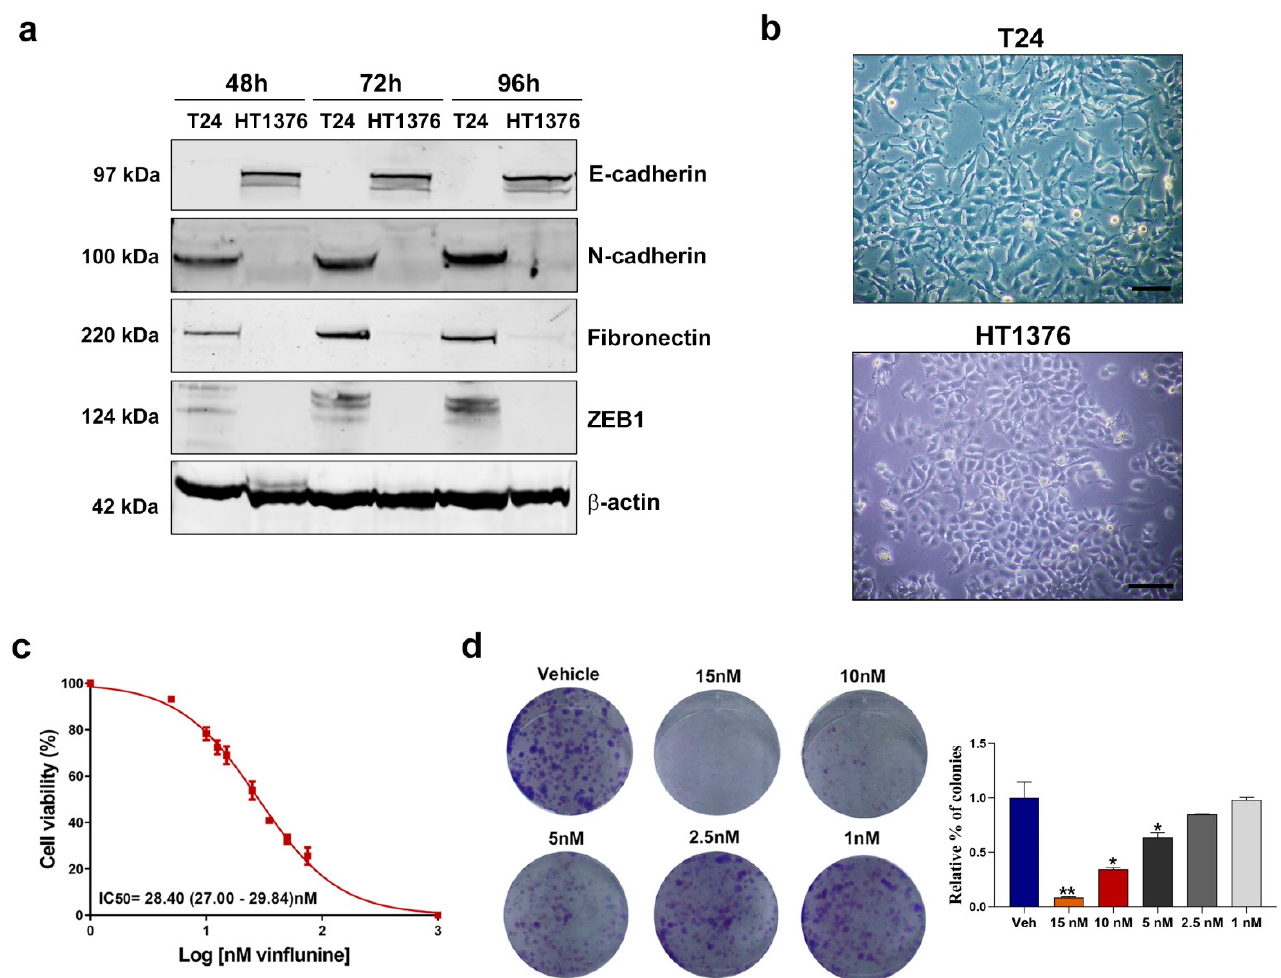
Figure 4. Basal protein expression levels of EMT markers in UCC cells and the effect of vinflunine on T24 cell proliferation. ( a ) Western blot analysis of E-cadherin, N-cadherin, Fibronectin and ZEB1 in T24 and HT1376 cells at 48, 72 and 96 h post-cell seeding. Beta-actin was used as endogenous control. ( b ) Phase-contrast microscopy images of the T24 and HT1376 cell lines. Scale bar: 50 µ m.( c ) Dose–response curve for T24 cells after vinflunine treatment at 0–100 nM for 72 h (mean ± SEM). IC50 value is shown as mean (95% CI). ( d ) Representative colony assay images (left) and bar graph (right) representing the percentage (mean ± SEM) of colonies in T24 cells after 72 h of vinflunine treatment at the indicated doses. * p < 0.05 and ** p < 0.01 relative to vehicle (veh) condition. All results were obtained from at least three independent experiments.